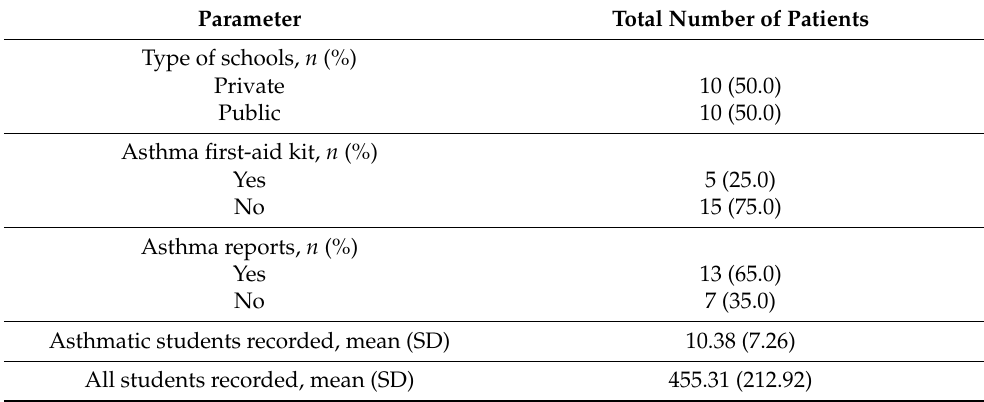
Table 2. Presence of asthma first-aid kit in schools.